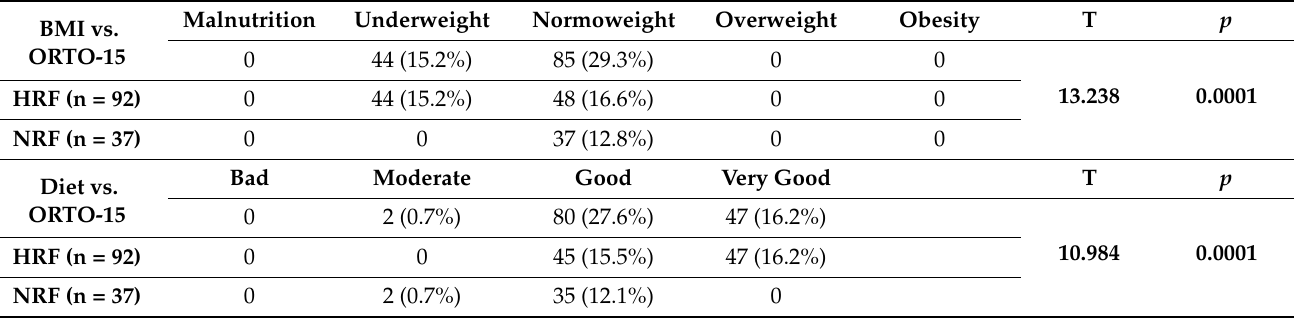
Table 3. Relationship between BMI and diet and the group at increased risk for orthorexia (n = 129) .